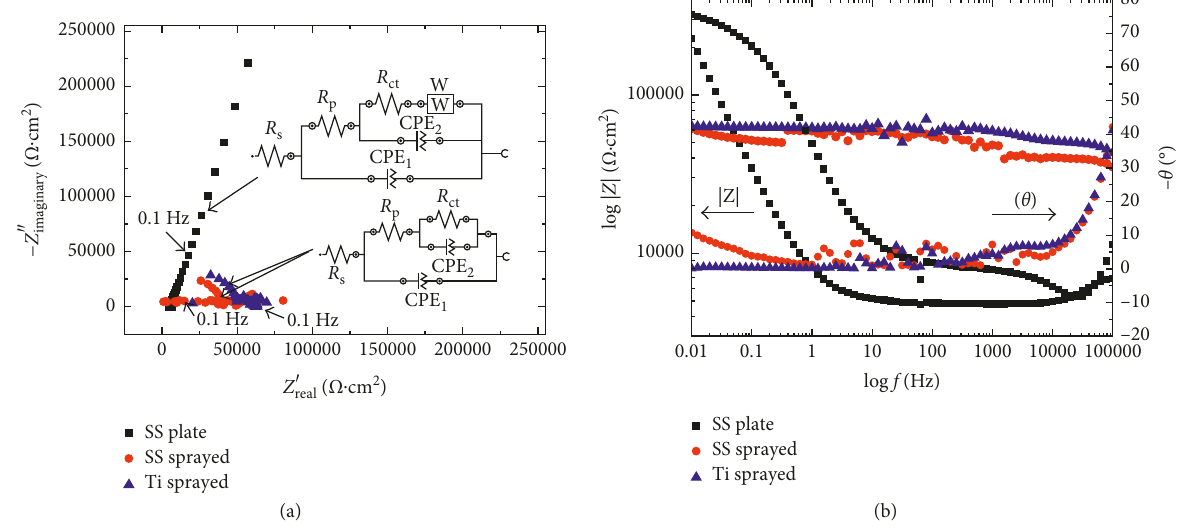
Figure 5: Impedance spectra: (a) Nyquist and (b) Bode | Z | and ( θ ) of the SS plate and sprayed coatings in pH 4 solution after 312h of exposure (100kHz to